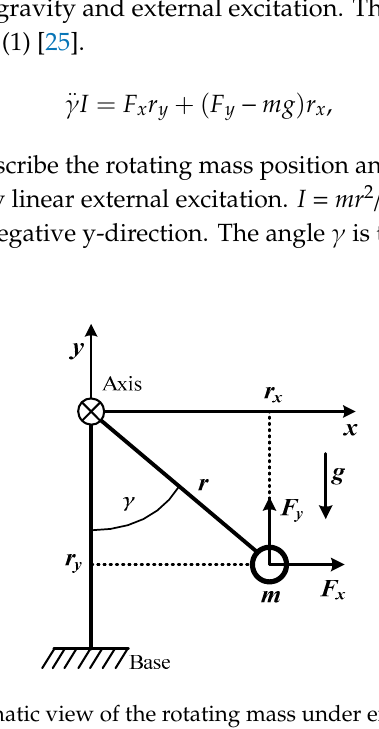
Figure 2. Schematic view of the rotating mass under external excitation.